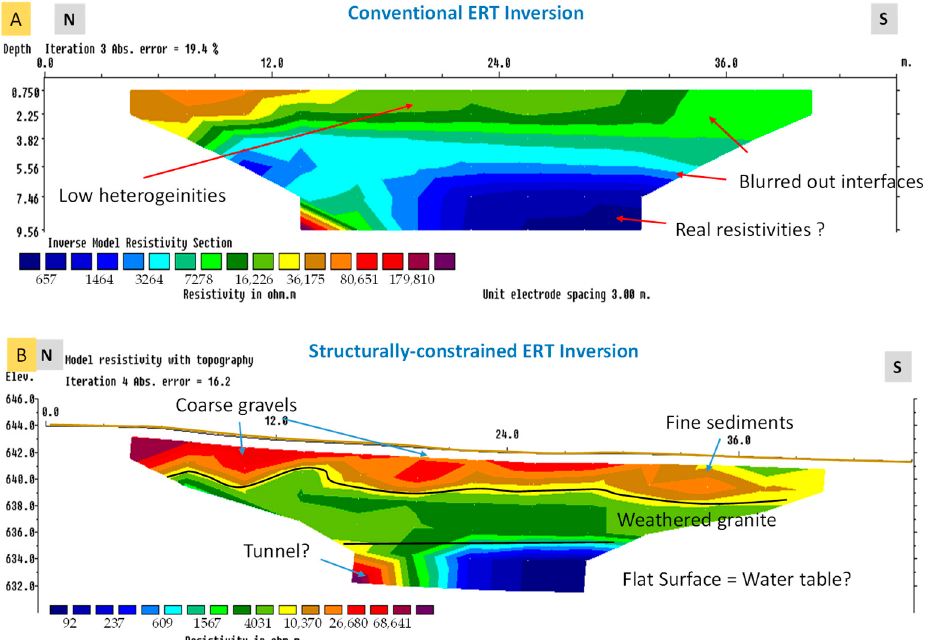
Figure 9. Results of the resistivity inversion of profile PE10 using ( A ) the conventional methodology and ( B ) the structure-controlled methodology.